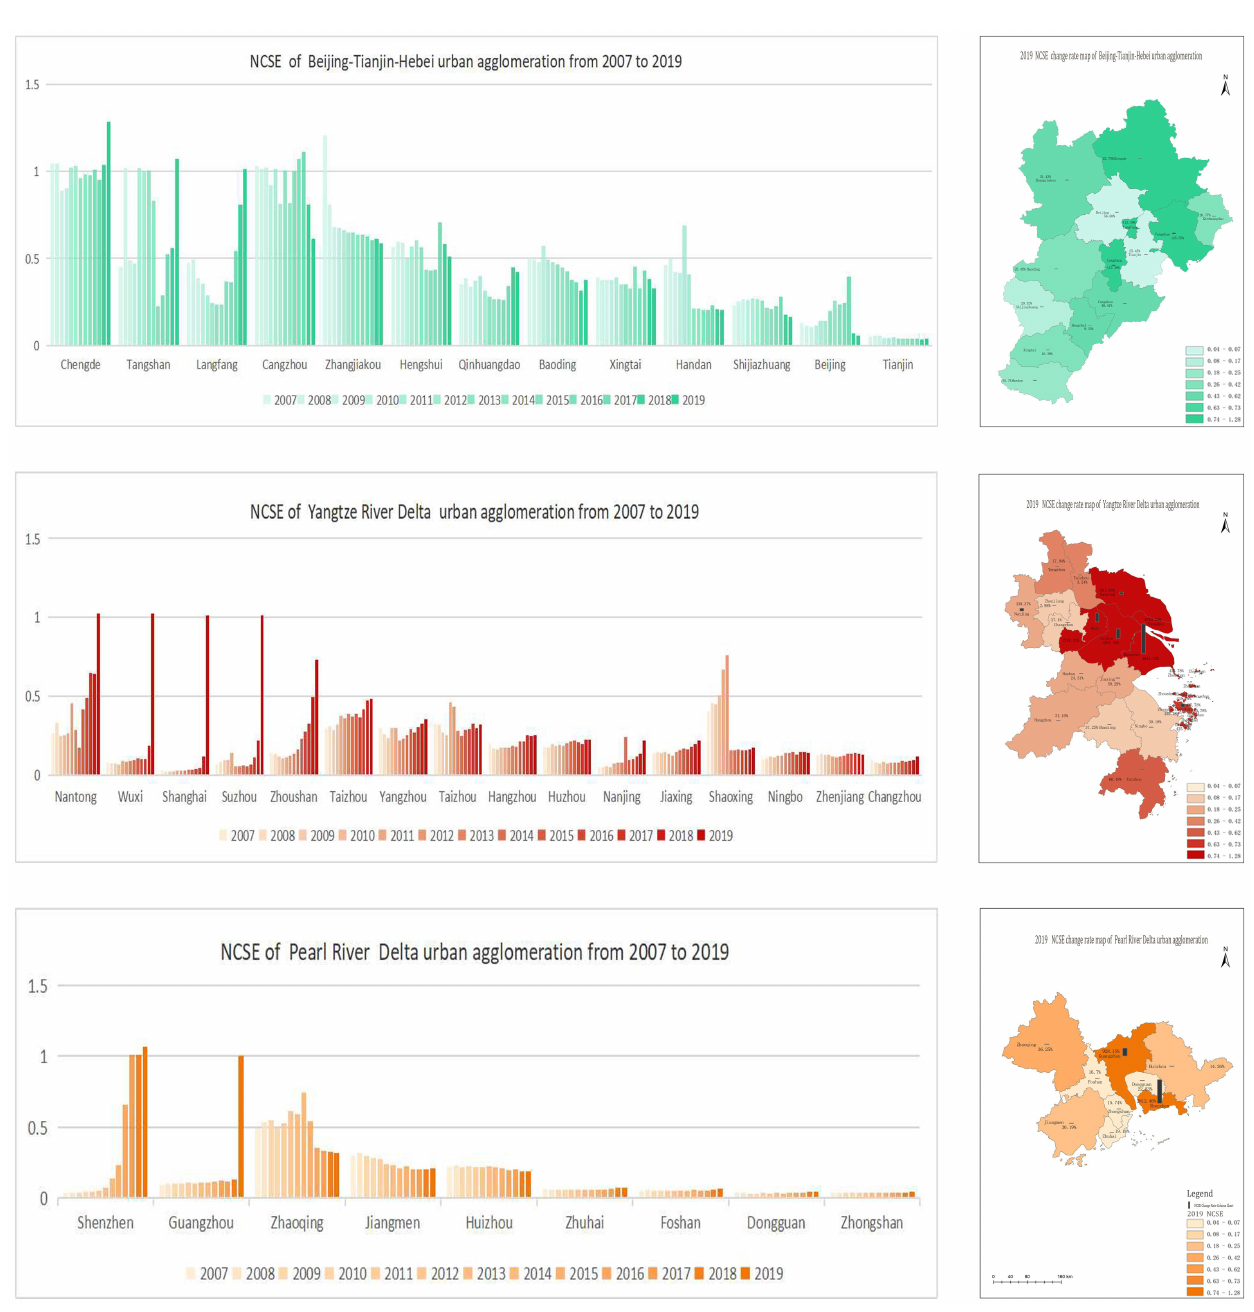
Figure 4. The NCSE maps of the three major UAs from 2007 to 2019. The regression results of the two-way fixed-effects model show that the influencing factors of the NCSE of the three major UAs were found to be significantly different (Table 5). The BTH UA was mainly influenced by the GDP per capita and industrial structure; the YRD UA was mainly influenced by the industrial structure; the PRD UA was mainly influenced by the population density, industrial structure, and technology level. The one- period-lagged robustness test of the model demonstrated that the correlation coefficients of each influencing factor were basically consistent with the results of the previous empirical analysis, and the significance of only some influencing factors had